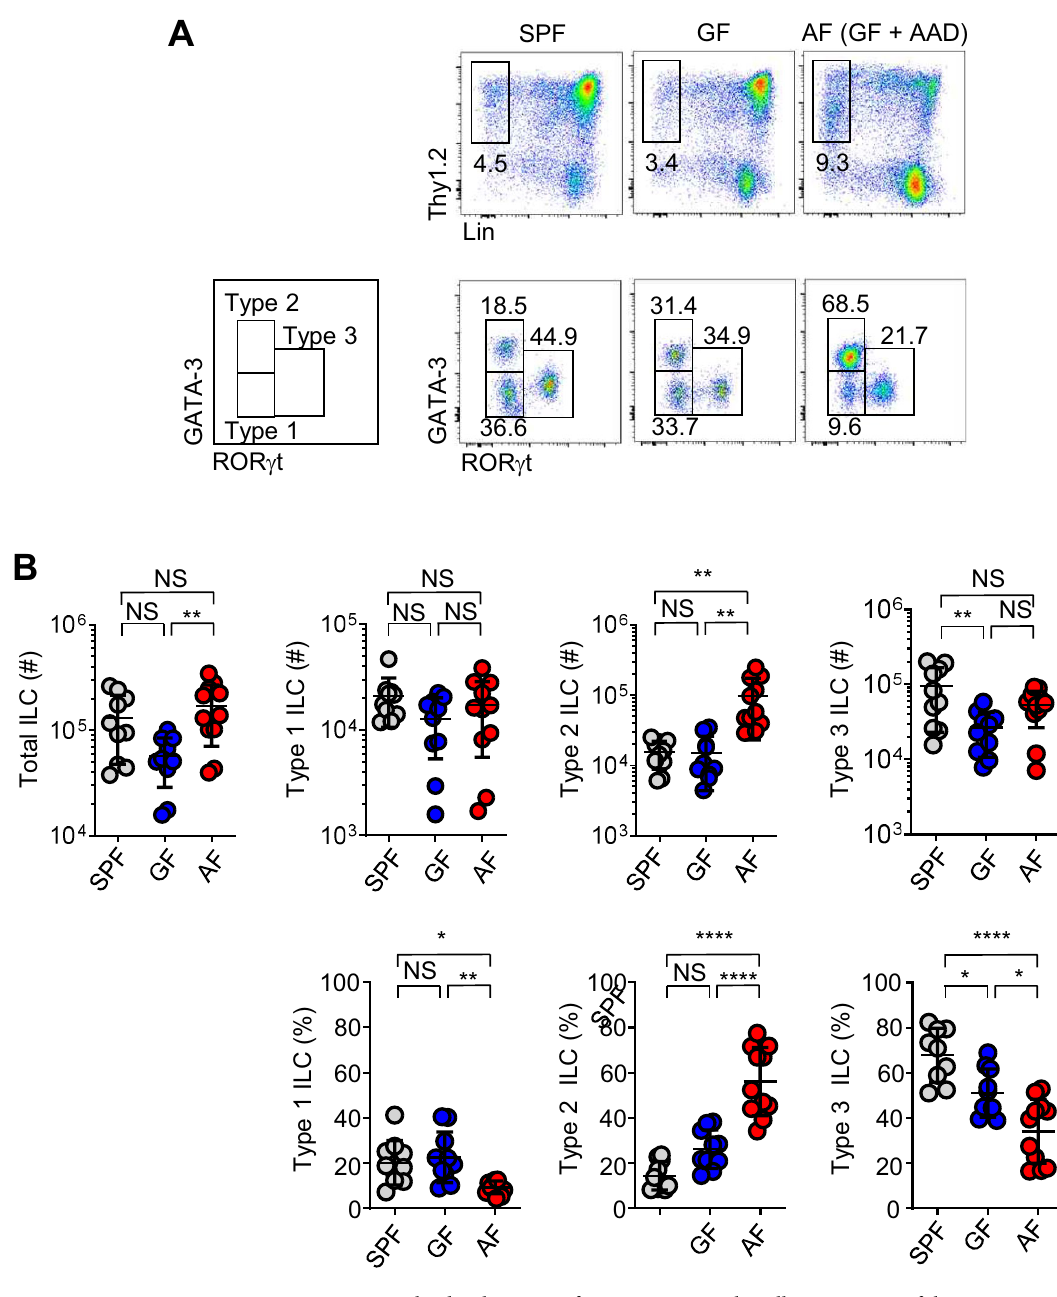
Figure 1. Dietary antigens suppress the development of type 2 ILCs. Single-cell suspensions of the siLP mononuclear cells isolated from young adult SPF, GF, and AF mice were analyzed by flow cytometry. ( A ) Representative dot plots show GATA-3 and RORγt expression on gated Lin − CD45 + Thy1.2 + cells from indicated mice. ( B ) Graphs show statistical analysis of numbers (upper) and frequencies (lower) of total and each ILC subset from SPF (n=10), GF (n=10), and AF (n=11) mice. Pooled results from three independent experiments are shown. Horizontal bars indicate mean values and error bars show SD. Each dot represents an individual mouse. NS.: not significant, * p <0.05, ** p <0.01, *** p <0.001, **** p <0.0001 (one-way ANOVA). siLP, small intestinal lamina propria; Lin, lineage; ILC, innate lymphoid cell; SPF, specific pathogen-free; GF, germ-free; AF, antigen-free; AAD, amino-acid diet; NCD, normal chow